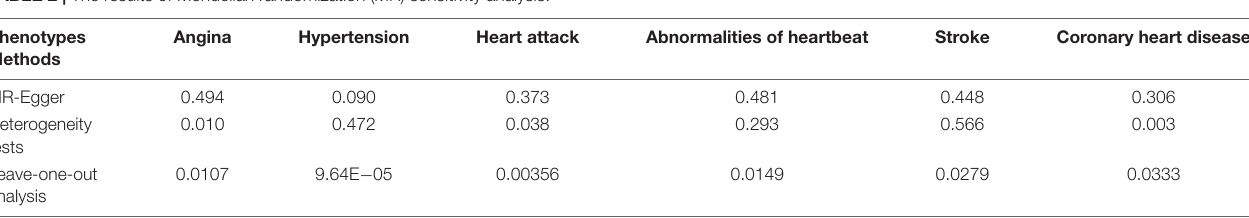
TABLE 2 | The results of Mendelian randomization (MR) sensitivity analysis.